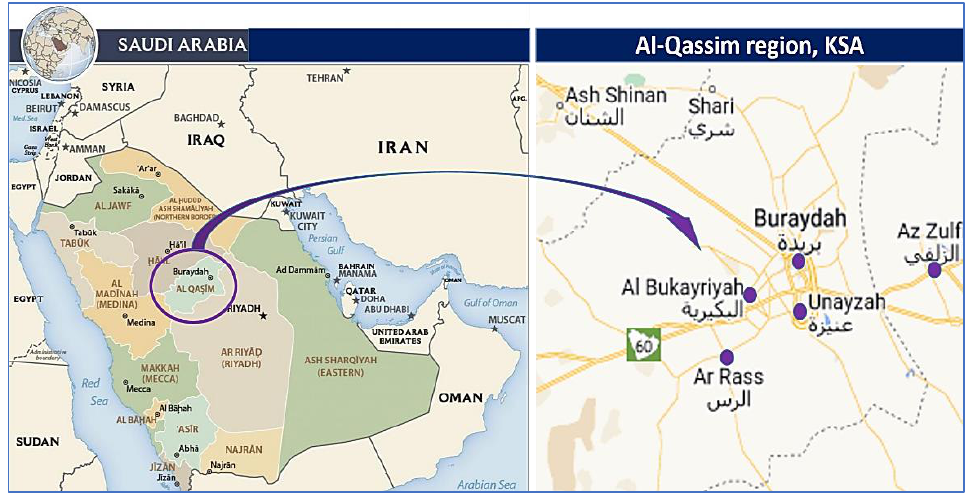
Figure 1. Map of Saudi Arabia with the Qassim region highlighted in purple and the study sites. Available online: maps-saudi-arabia.com/al-qassim-saudi-arabia-map (accessed on 17 February 2021).